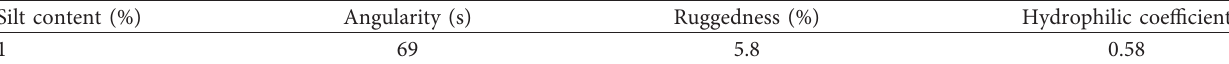
Table 2: Technical indexes of fine aggregates.